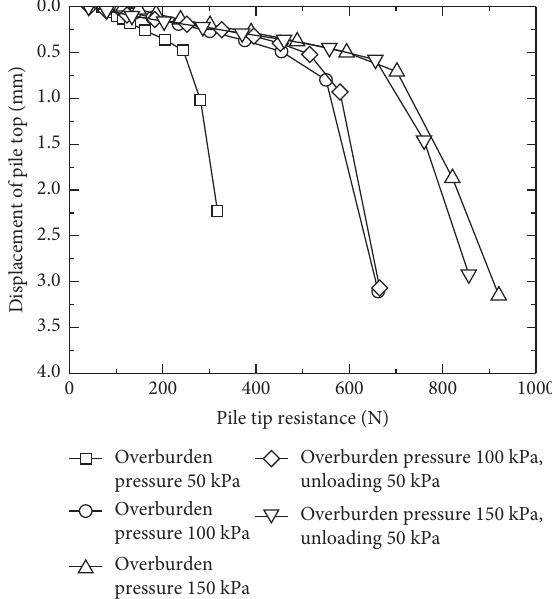
Figure 16: Pile tip resistance versus displacement of pile